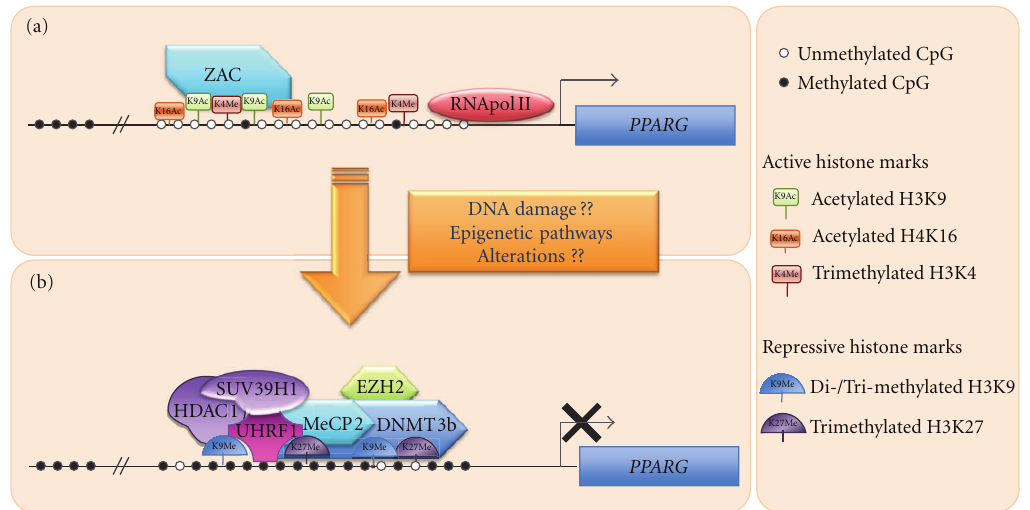
Figure 3: Schematic drawing of the proposed mechanism(s) involved in PPARG silencing. (a) In PPAR γ -expressing cells, the unmethylated or partially methylated core promoter is bound by still unknown transcriptional factors, among which only the zinc-finger protein ZAC has been identified. Active histone marks, such as H3K9ac, H3K4me3 and H4K16ac are present together with the RNA polimerase II. (b) Upon unknown stimuli, the PPARG promoter becomes hypermethylated, enriched in H3K9me2, H3K9me3 and H3K27me3. Furthermore, a repressive complex containing UHRF1, MeCP2, DNMT3b, HDAC1, SUV39H1 and EZH2 is recruited inducing transcription repression. Partially adapted from reference